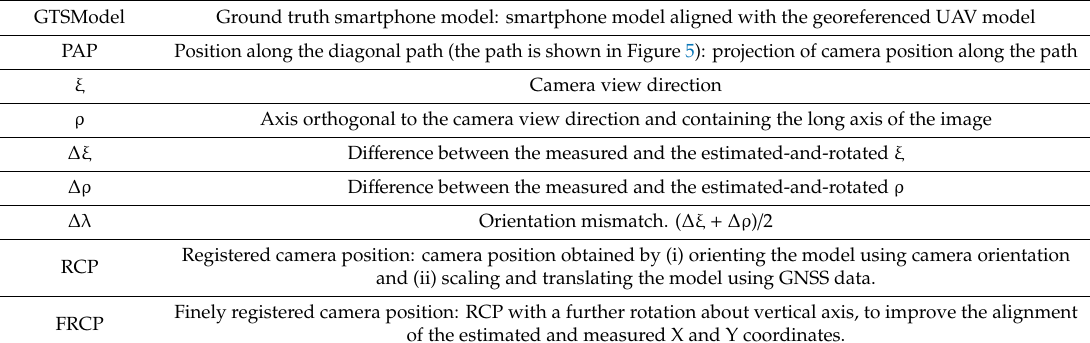
Table 1. Parameters and acronymous